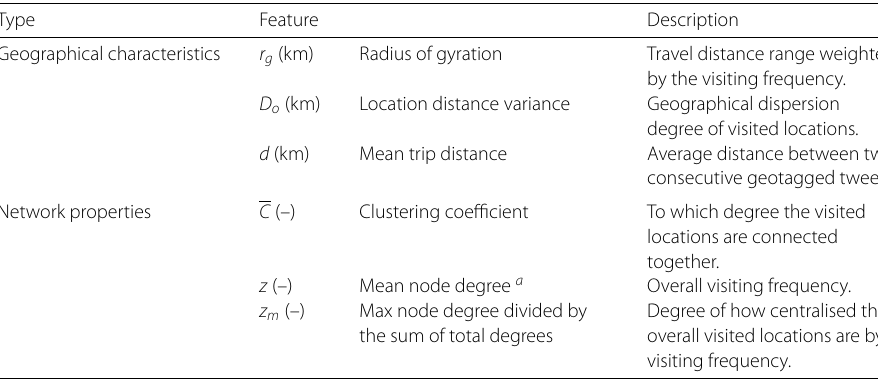
Table 2 Spatial features characterising individual’s activity patterns. The node degree ( a ) is equivalent to the location visiting